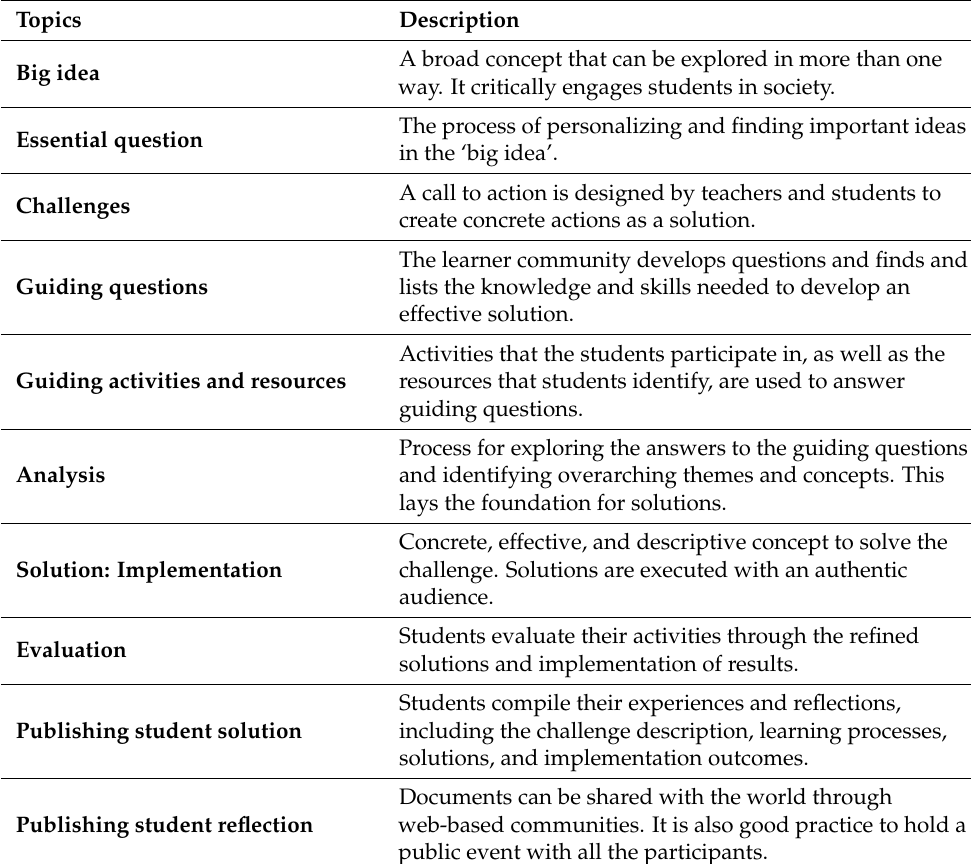
Table 2. CBL topics and description (adapted from Nichols et al., 2016)